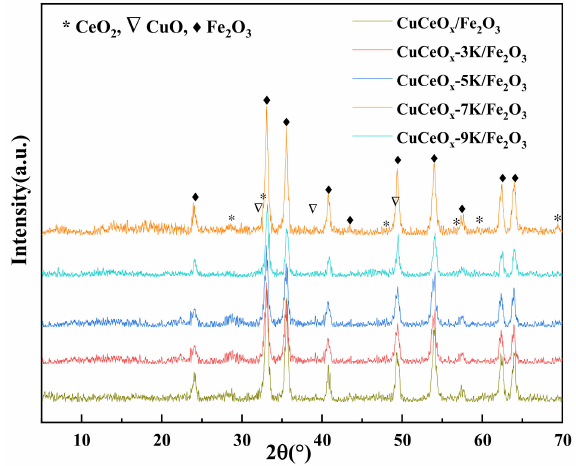
Figure 2. XRD patterns of the CuCe-xK/Fe 2 O 3